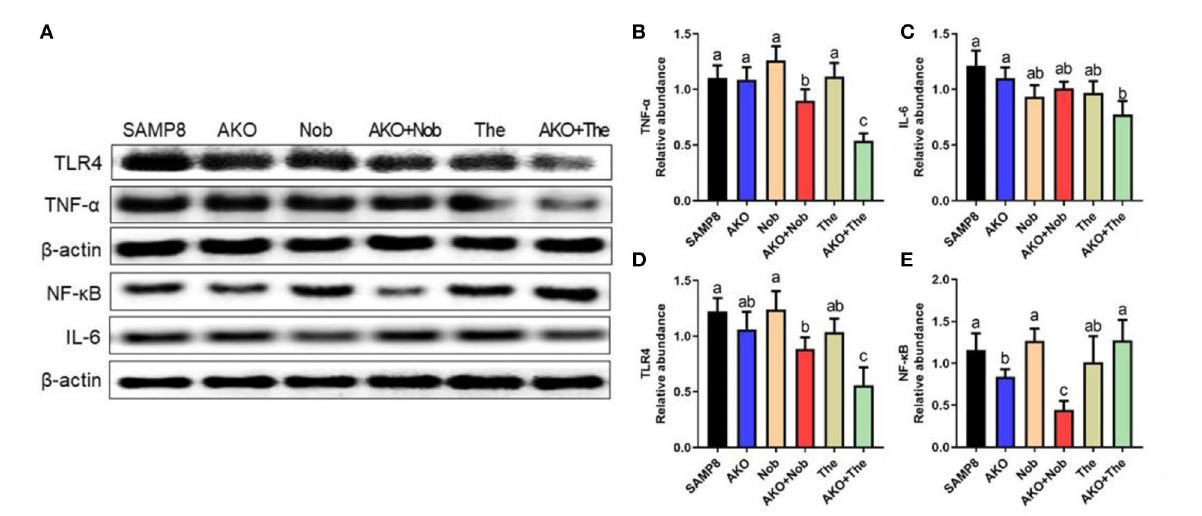
FIGURE7 Effects of neuroinflammation in the brain. (A) The representative bands were determined by western blotting. (B–E) The relative expressions of tumor necrosis factor- α (TNF- α ) (B) , interleukin-6 (IL-6) (C) , Toll-like receptor 4 (TLR4) (D) , and nuclear factor- κ B (NF- κ B) (E) . All data were presented as mean ± SEM. Different letters indicate a significant difference at p < 0.05 by ANOVA.